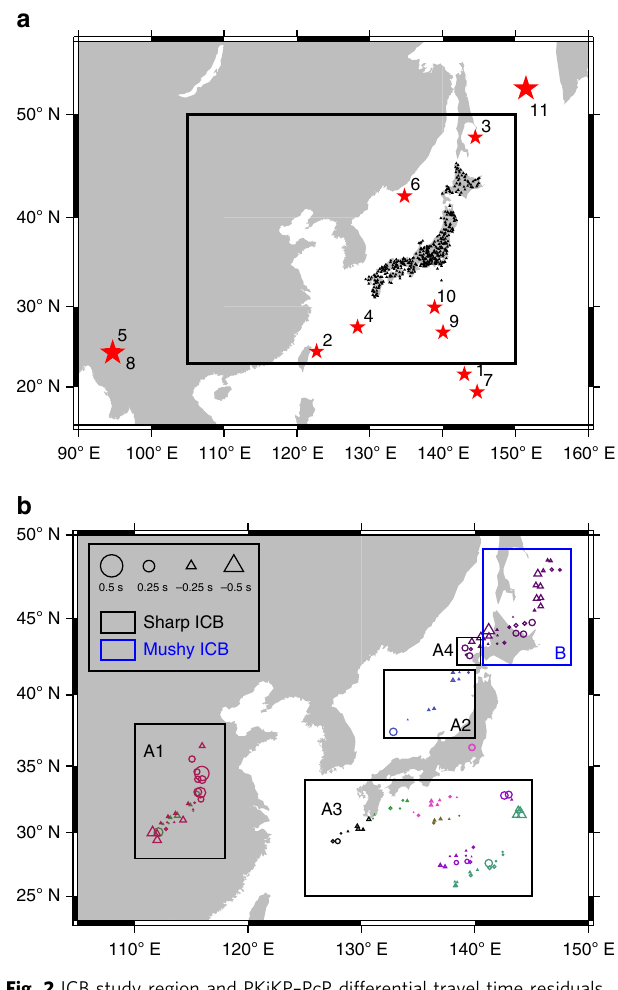
Fig. 2 ICB study region and PKiKP – PcP differential travel time residuals. a Map view of the ICB study region ( solid black box , with detailed results shown in Fig. 2b), along with seismic events ( red stars , labeled by event ID listed in Supplementary Table 1) and stations ( black triangles ) used in the analyses. b Geographic distribution of PKiKP – PcP differential travel time residuals in the study region (corresponding to the solid black box in Fig. 2a), averaged over caps with a radius of 1° covering the PKiKP re fl ected points at the ICB (Supplementary Fig. 1 for a complete version). Cap-averaged residuals are plotted at the center of each cap and color-coded with each event, with positive and negative values denoted by circles and triangles respectively and the size of the symbol proportional to the absolute value of travel time residual. The ICB is grouped into regions according to their structural characteristics inferred based on seismic data, with black boxes (labeled as A: A1, A2, A3, and A4) indicating fl at and sharp regions and blue box (labeled as B) a region with a laterally varying double-layered structure (mushy zone) across the